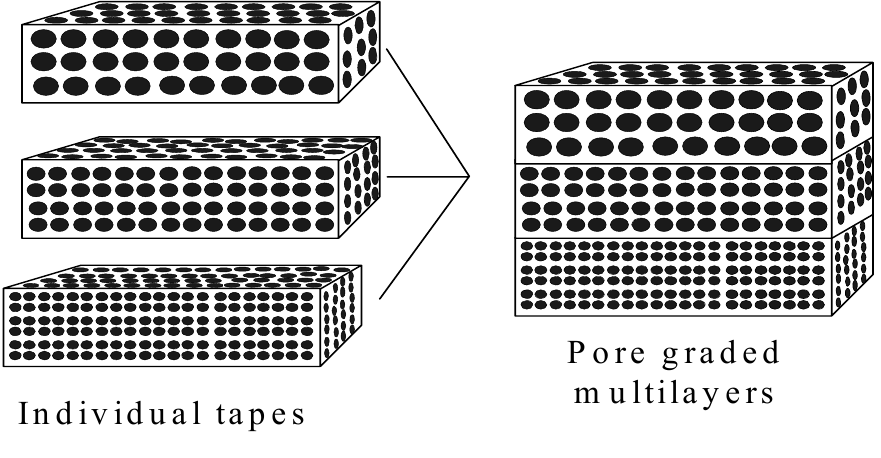
Figure 9. Schematic illustration of the fabrication of pore graded multilayers by lamination of individual tapes, manufactured by tape